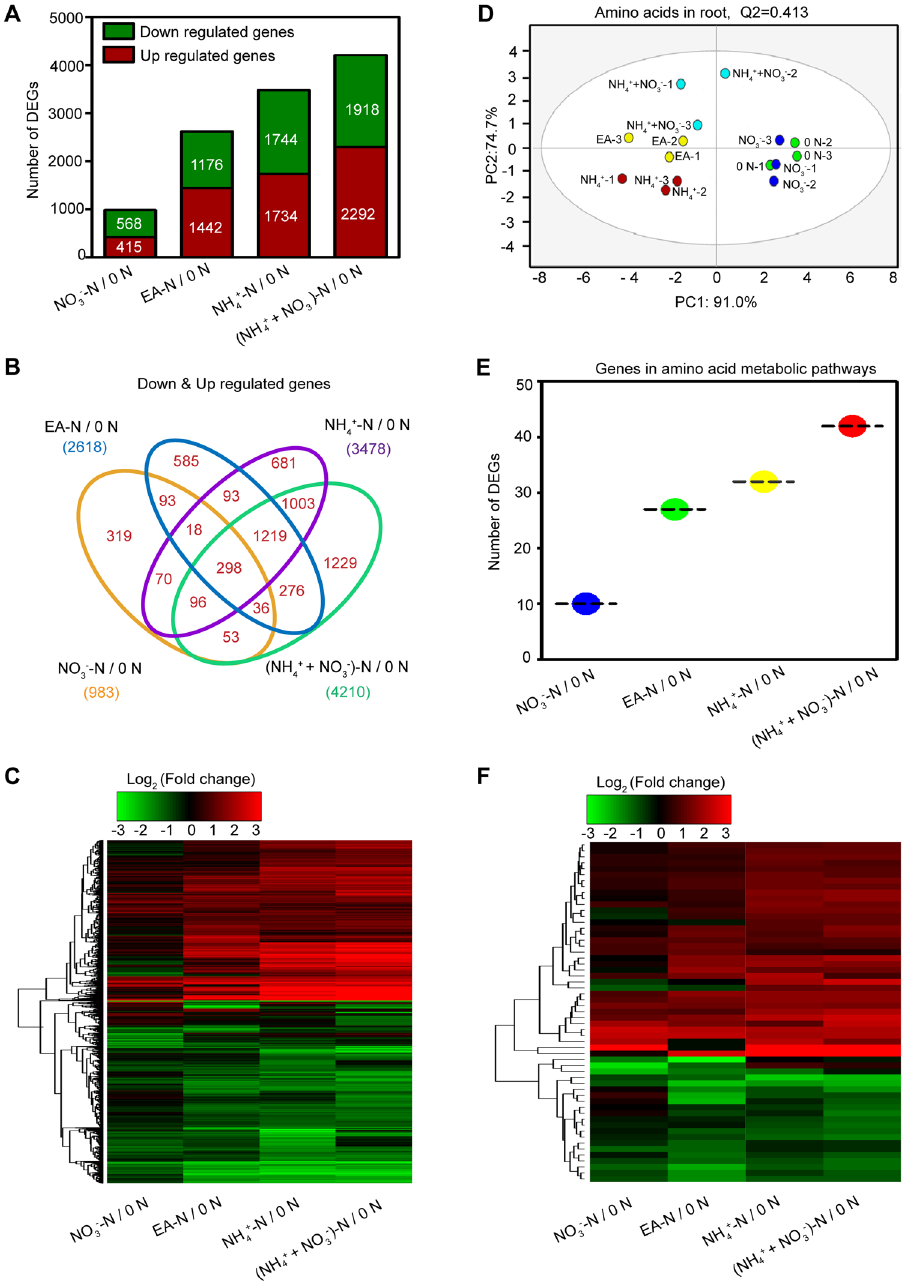
Figure 4. An overview on differentially expressed genes responsive to different forms of N in tea plant root. ( A ) The number of DEGs was examined in the comparisons between 0 N and each form of N in tea root. DEGs, differentially expressed genes. ( B ) Venn diagram showing distribution of DEGs in the comparisons between 0 N and various forms of N treatments. ( C ) Hierarchical clustering represents relative expression levels of DEGs in comparisons between 0 N and various N forms. The FPKM ratio of gene expression is represented on a logarithmic scale for treatments with different N forms ( NO 3 − -N, EA-N, NH 4 + -N, and [NH 4 + + NO 3 − ]-N) relative to the control (0 N) (log 2 adj FPKM N forms / adj FPKM 0 N ). adj FPKM, adjusted Fragment Per Kilo base of exon model per Million mapped reads. Red indicates a gene up-regulated at that treatment, while green indicates down-regulated expression. ( D ) The OPLS-DA analysis of amino acids in tea plant roots under treatments with different forms of N. Data shown are from the value of three biological replicates (n = 3). OPLS-DA analysis was performed by SIMCA 13.0 (UMETRICS, https://umetrics.com/). ( E ) Numbers of DEGs related to amino acids metabolism were calculated in the comparisons between 0 N and various forms of N treatments. ( F ) Hierarchical clustering representing relative expression levels of DEGs related to amino acids